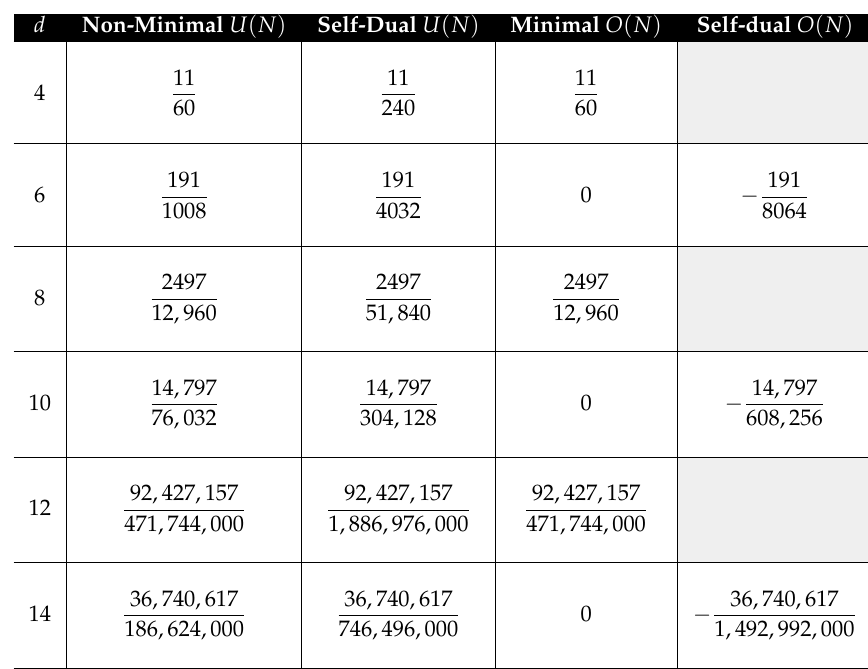
Table A2. Type C Casimir energies. The grey boxes indicate that the particular type of p -form is not defined for the